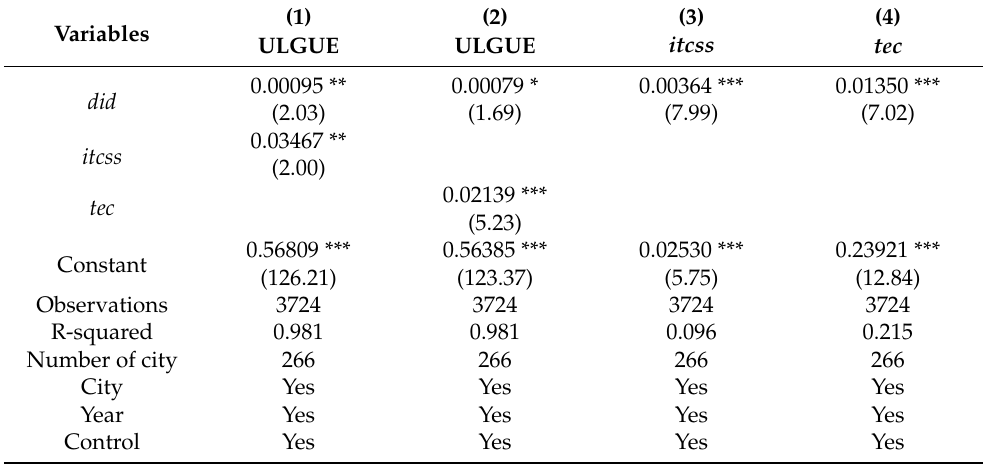
Table 8. Empirical analysis of impact of technological innovation on ULGUE.